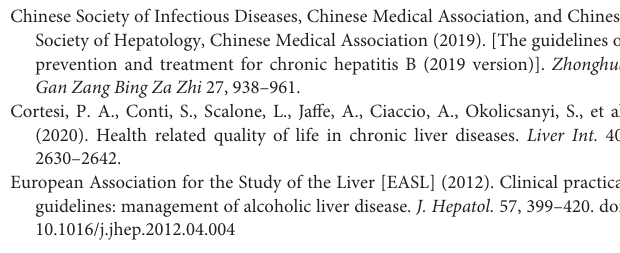
Supplementary Figure 1 | The difference of HRQoL between CHB patients and HBV-related cirrhosis patients. (A) PF score in cirrhosis was significantly lower than in CHB patients (89.09 ± 13.33 vs. 93.12 ± 10.63, P = 0.002), similar in VT score (64.69 ± 18.89 vs. 70.53 ± 16.96, P = 0.004), SF score (73.69 ± 21.89 vs. 79.41 ± 19.15, P = 0.013) and in total score (73.07 ± 14.19 vs. 77.44 ± 13.61, P = 0.006). (B) Physiological HRQoL in cirrhosis patients was 79.11 ± 12.15, significantly lower than in CHB patients of 83.49 ± 10.77 ( P = 0.003), similar in psychological HRQoL (72.49 ± 13.68 vs. 77.59 ± 12.88, P = 0.006). (C) Liver stiffness was significantly negative correlated with HRQoL ( R = -0.21, P = 0.001). Supplementary Figure 2 | Impaired dimensions of HRQoL caused by HBV DNA and family history. (A) RP score in positive HBV DNA viral load patients was 66.67 ± 32.57, significantly lower than negative HBV DNA viral load patients with 86.51 ± 19.34 ( P = 0.004). (B) VT score in HCC family history was 53.75 ± 17.47, lower than the others with 68.28 ± 18.52 ( P = 0.013), similar in SF score (61.11 ± 18.65 vs. 77.05 ± 21.57, P = 0.018), RE score (69.44 ± 26.43 vs. 85.09 ± 23.97, P = 0.041), and MH score (57.33 ± 11.97 vs. 67.16 ± 17.16, P =